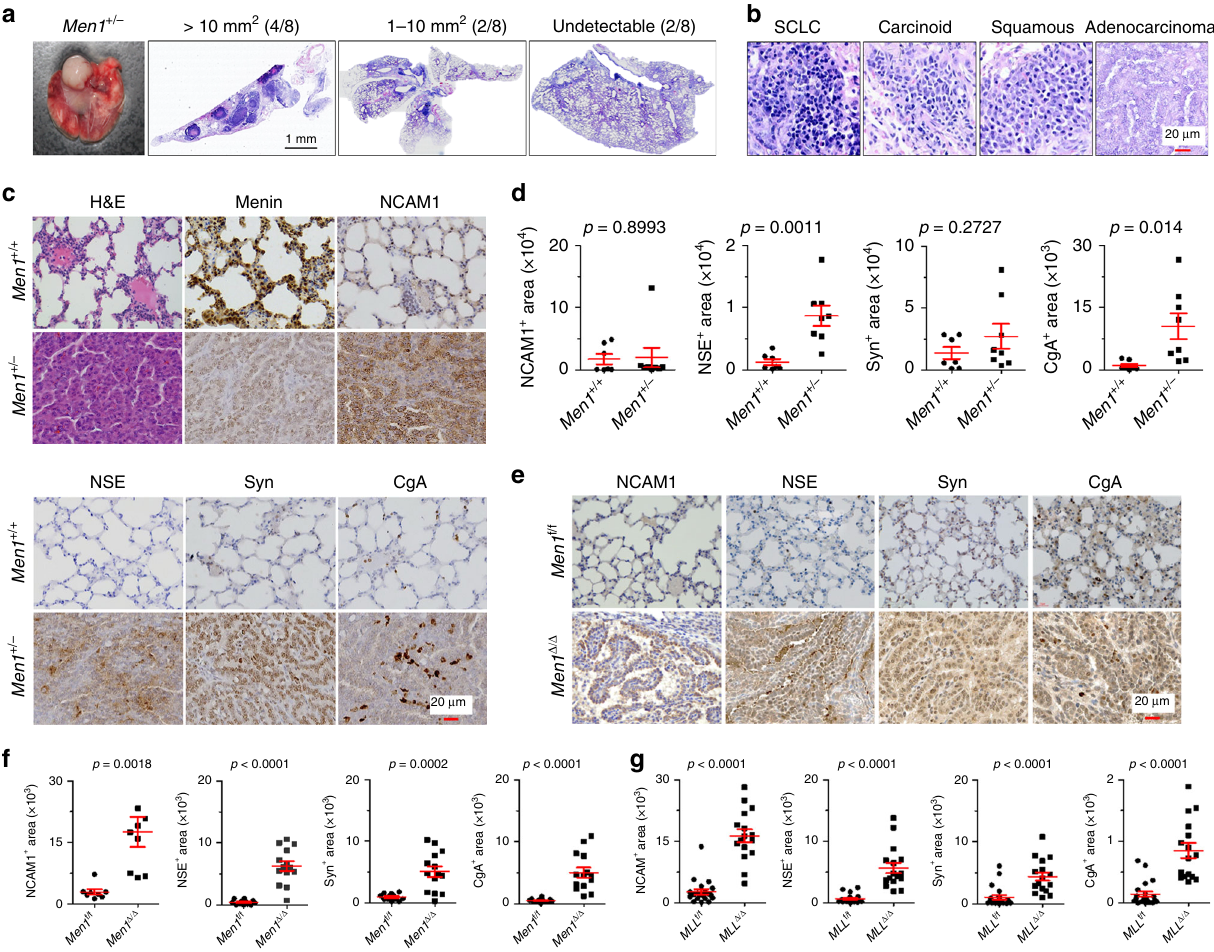
Fig. 1 Loss of Men1 induces mixed-type lung cancers with NE pro fi les. a Representative bright fi eld image and H&E images of lungs dissected from Men1 + / − mice at 12 – 18 months ( n = 8). The mice are grouped by tumor area: >10 mm 2 (4/8), 1 – 10 mm 2 (2/8), or undetectable (2/8). Scale bars, 1mm. b H&E staining of multiple pathological types of lung cancers from Men1 + / − mice, including SCLC, carcinoid cancer, squamous cell carcinoma, and adenocarcinoma. The samples were blindly classi fi ed by three independent pathologists. Scale bars, 20 μ m. c H&E and IHC staining of the indicated antibodies in the lungs of Men1 + / + and Men1 + / − mice. n = 8; Scale bars, 20 μ m. d Automatic quanti fi cation of NCAM1, NSE, Syn, CgA IHC staining in Men1 + / + and Men1 + / − 12 – 18 months mice lung tissues. e IHC staining of the indicated antibodies in Men1 f/f ( n = 12) and Men1 Δ / Δ ( n = 14) mice at 12 months post intraperitoneal (i.p.) injections of 100 mg/kg TAM. Scale bars, 20 μ m. f Automatic quanti fi cation of NCAM1, NSE, Syn, CgA IHC staining in Men1 f/f ( n = 12) and Men1 Δ /